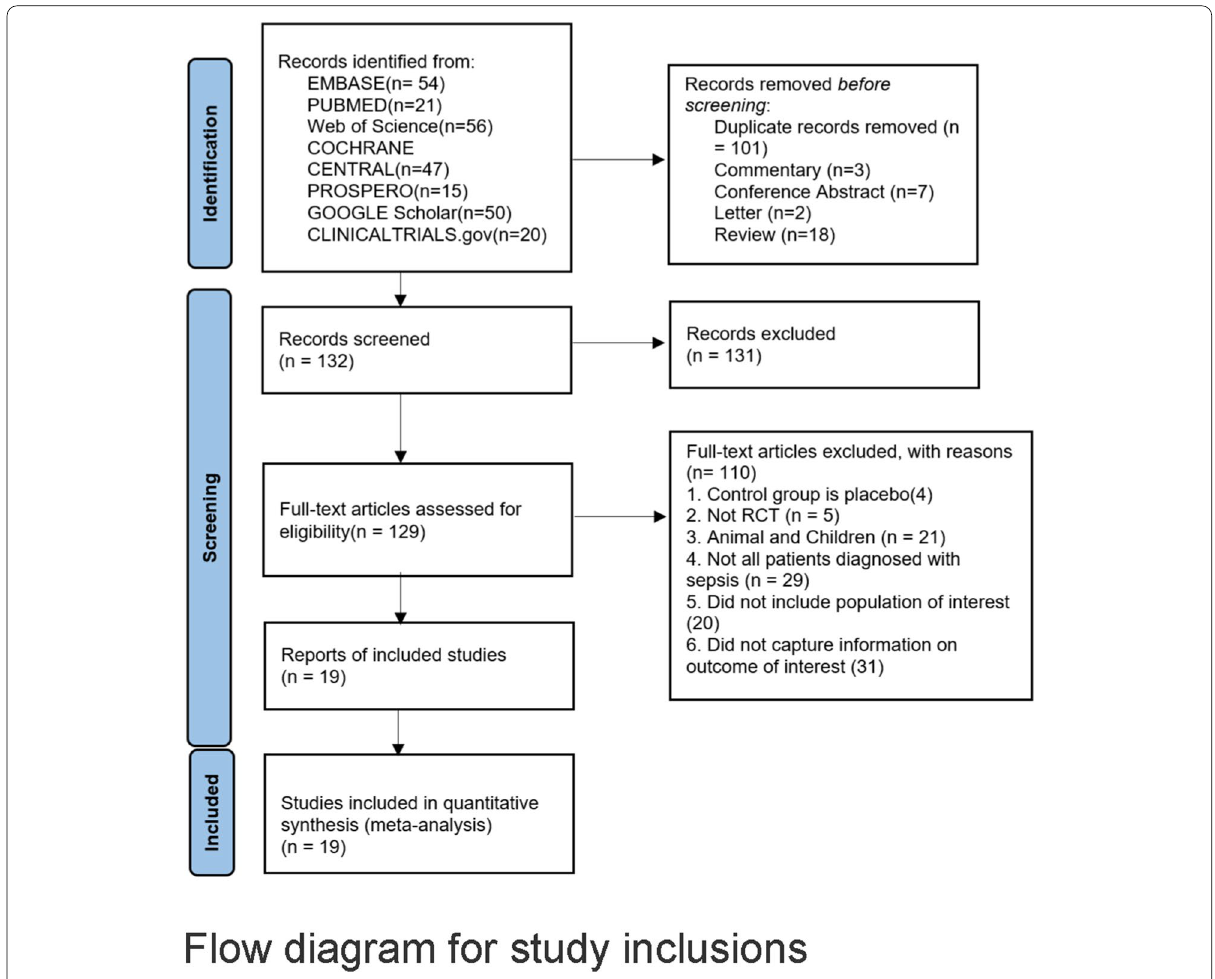
Fig. 1 Flow diagram for study